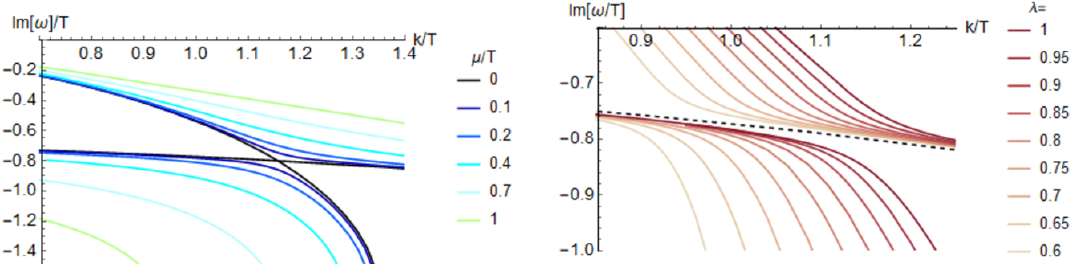
Figure 5 . Zoom on the dispersion relations at (cid:11)=T = 3. Left: the opening of the gap at di(cid:11)erent values of (cid:22)=T at (cid:12)xed (cid:21) = 1. Right: the gap for di(cid:11)erent strengths of EM coupling (cid:21) , at (cid:22)=T = 0 : 1. The dashed line indicates the decoupled mode found at (cid:22)=T = 0 (independent of (cid:21) ).